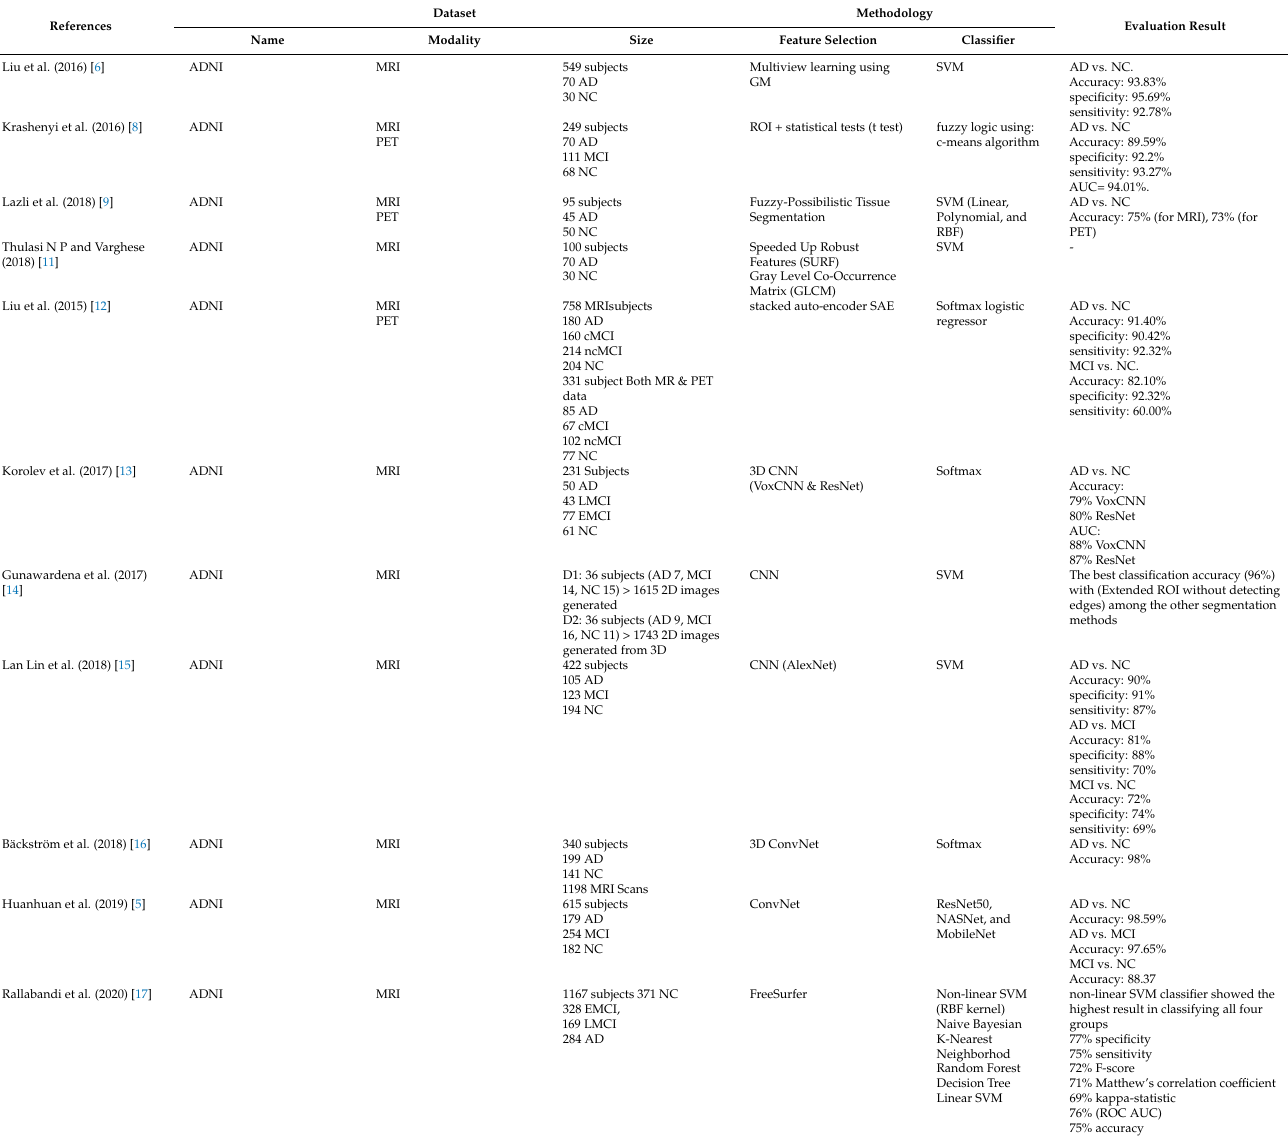
(2) methodology (feature selection and classifier), and (3) performance evaluation results. Table 1. Summary and comparison of the selected recent